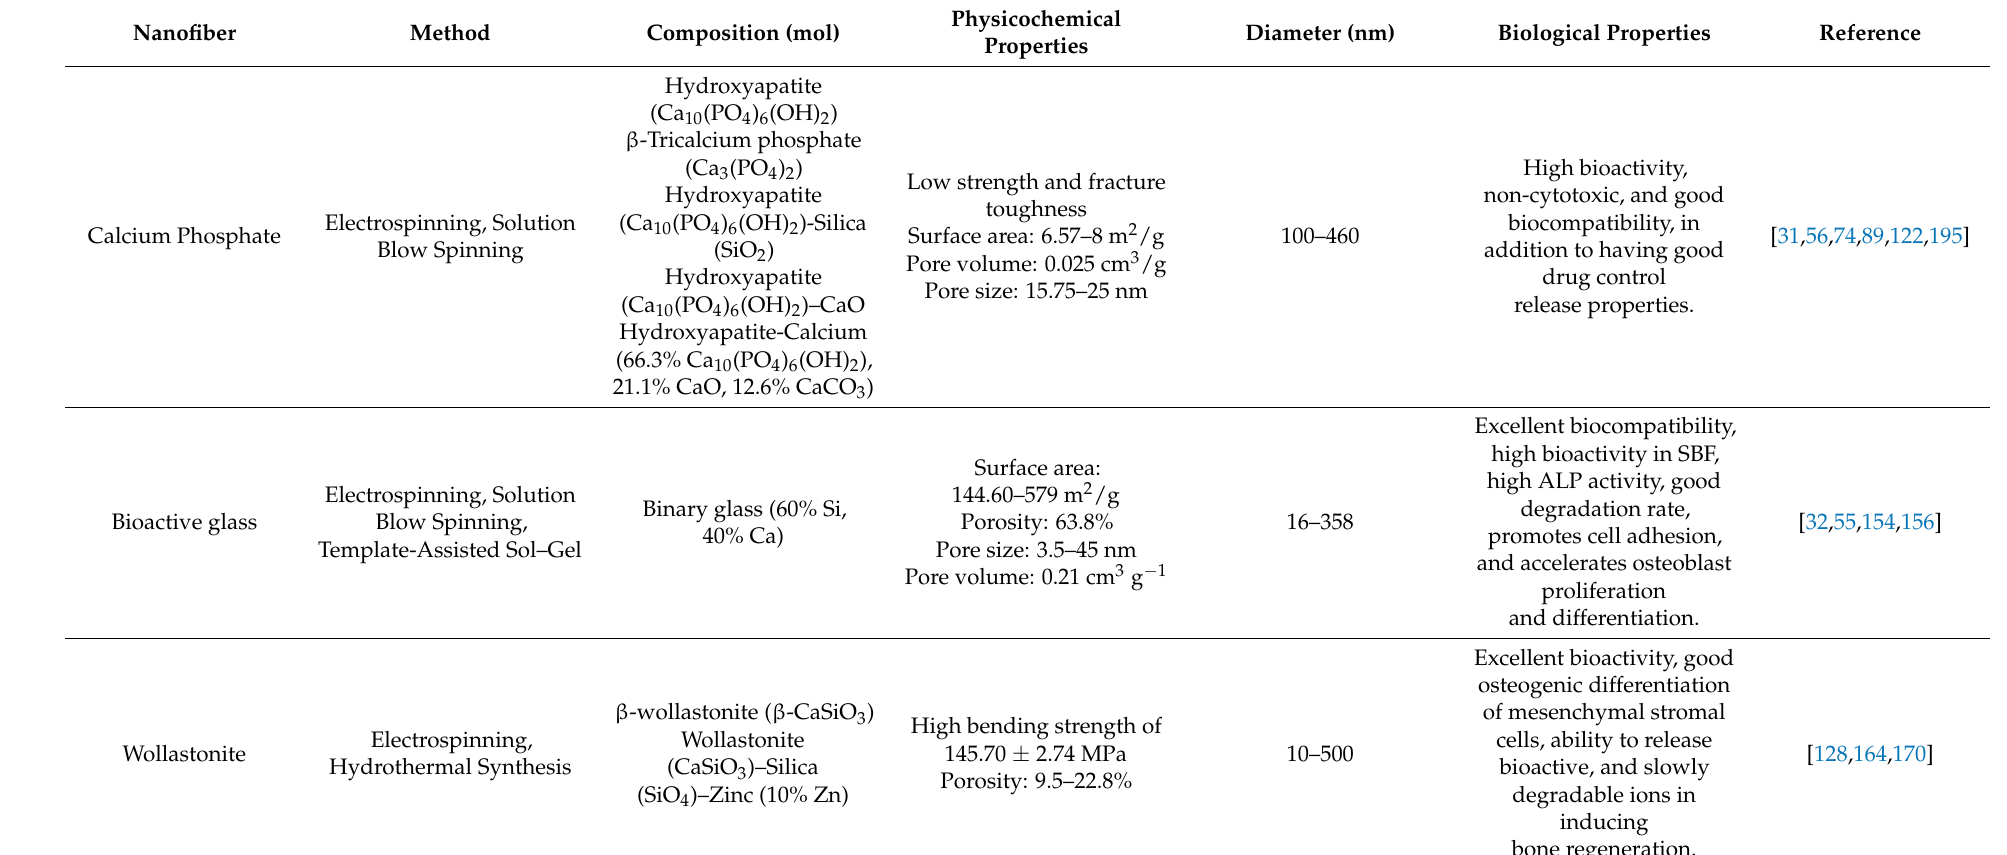
Table 2. Summary information about ceramic nanofibers for application in bone tissue